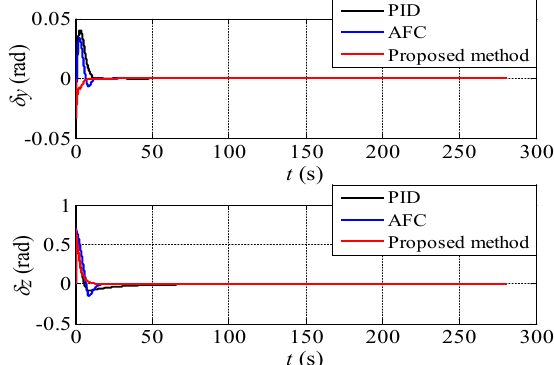
Figure 8. Attack guidance trajectories for the horizontal uniform linear motion of the target.